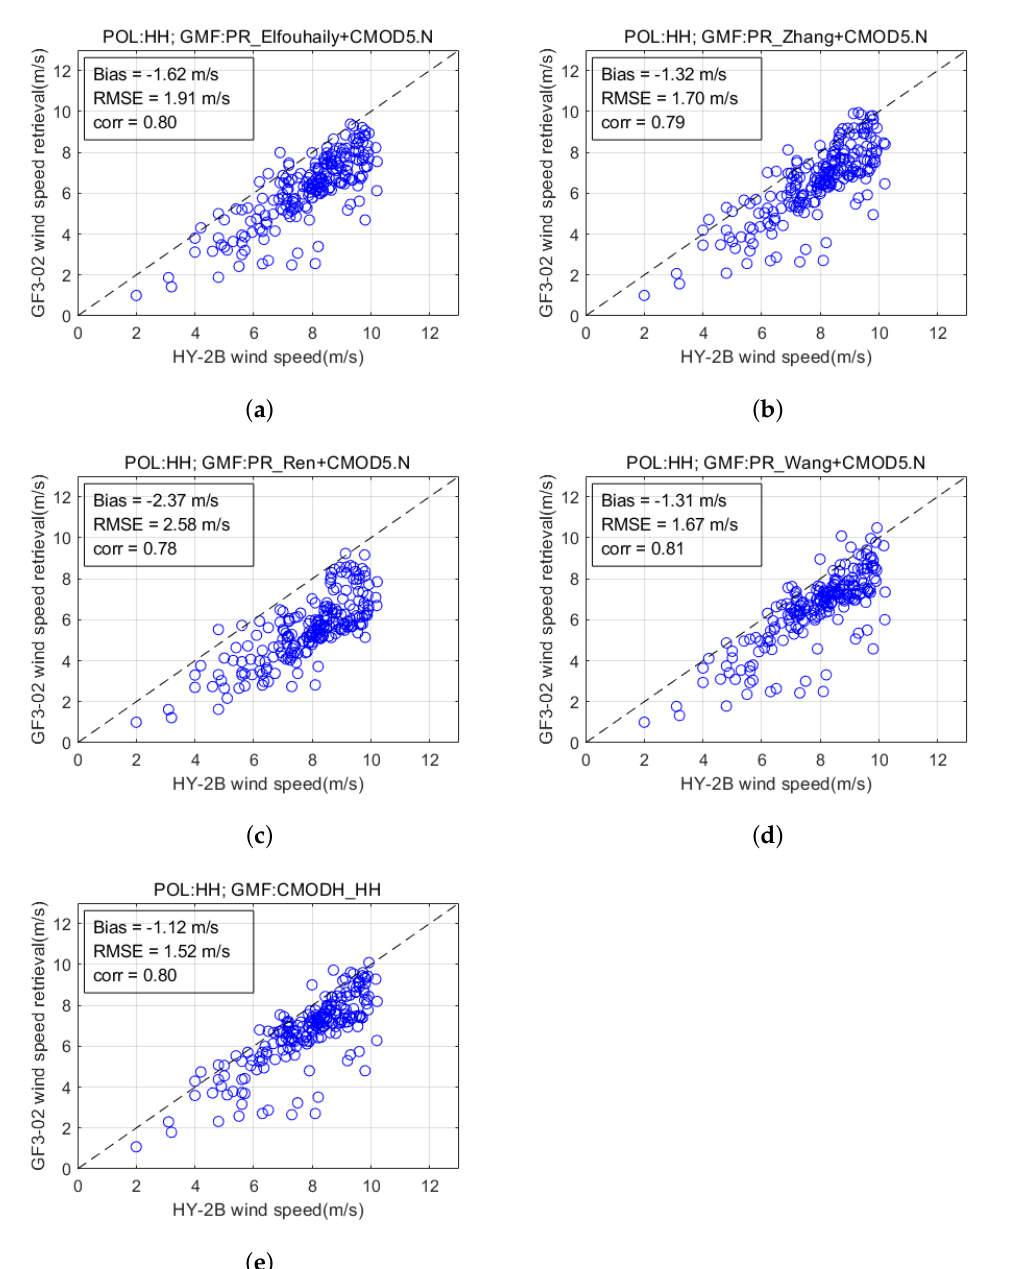
Figure 7. Comparison of wind speed retrieval results from GF3-02 HH polarization data based on ( a ) CMOD5.N+PR_Elfouhaily, ( b ) CMOD5.N+PR_Zhang, ( c ) CMOD5.N+PR_Ren, ( d ) CMOD5.N+PR_Wang, and ( e ) CMODH_HH and HY-2B SCA wind